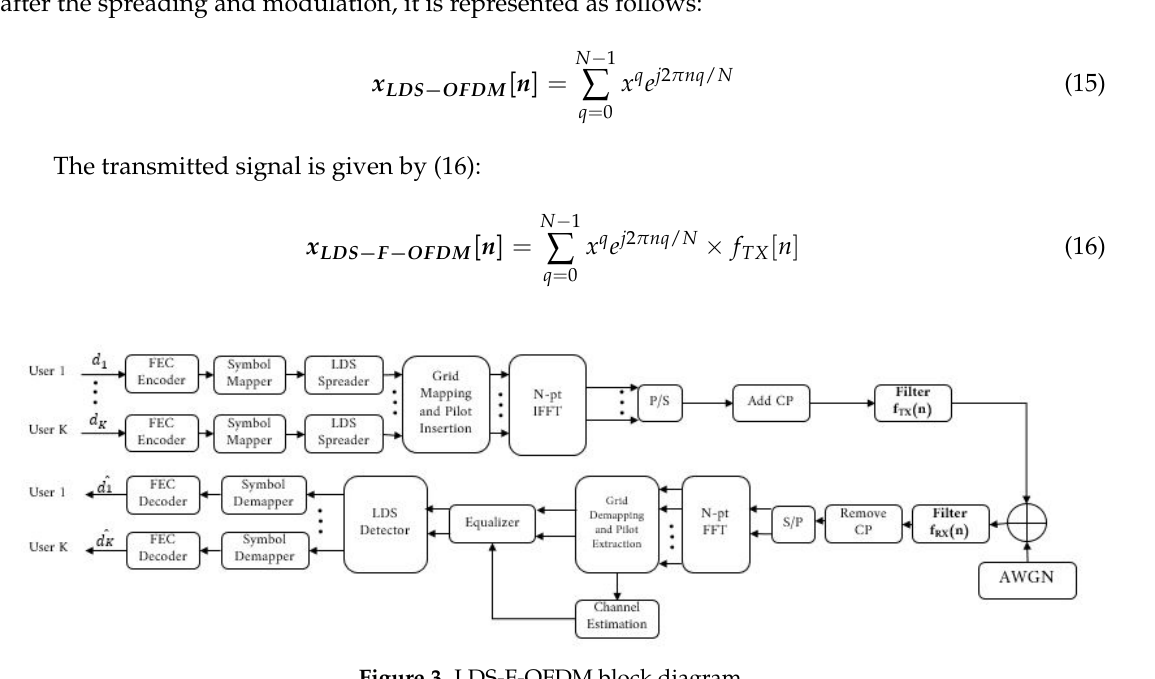
Figure 3. LDS-F-OFDM block